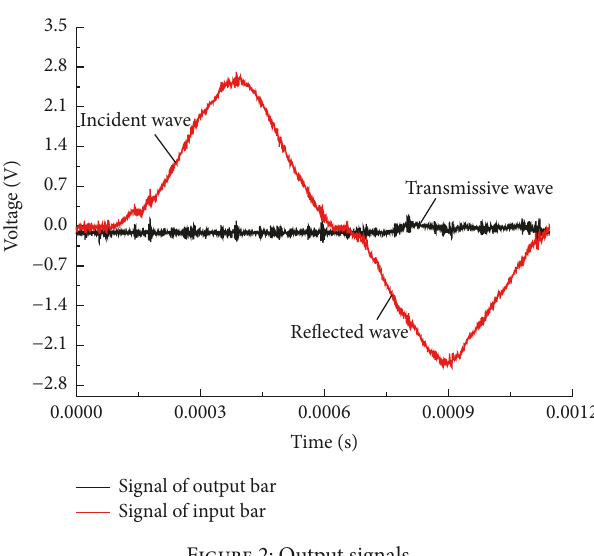
Figure 2: Output